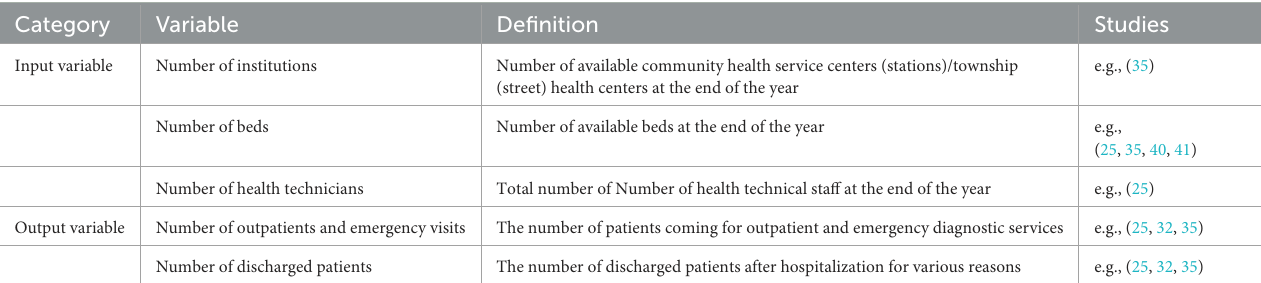
TABLE 1 Input and output variables for the DEA- Malmquist model.